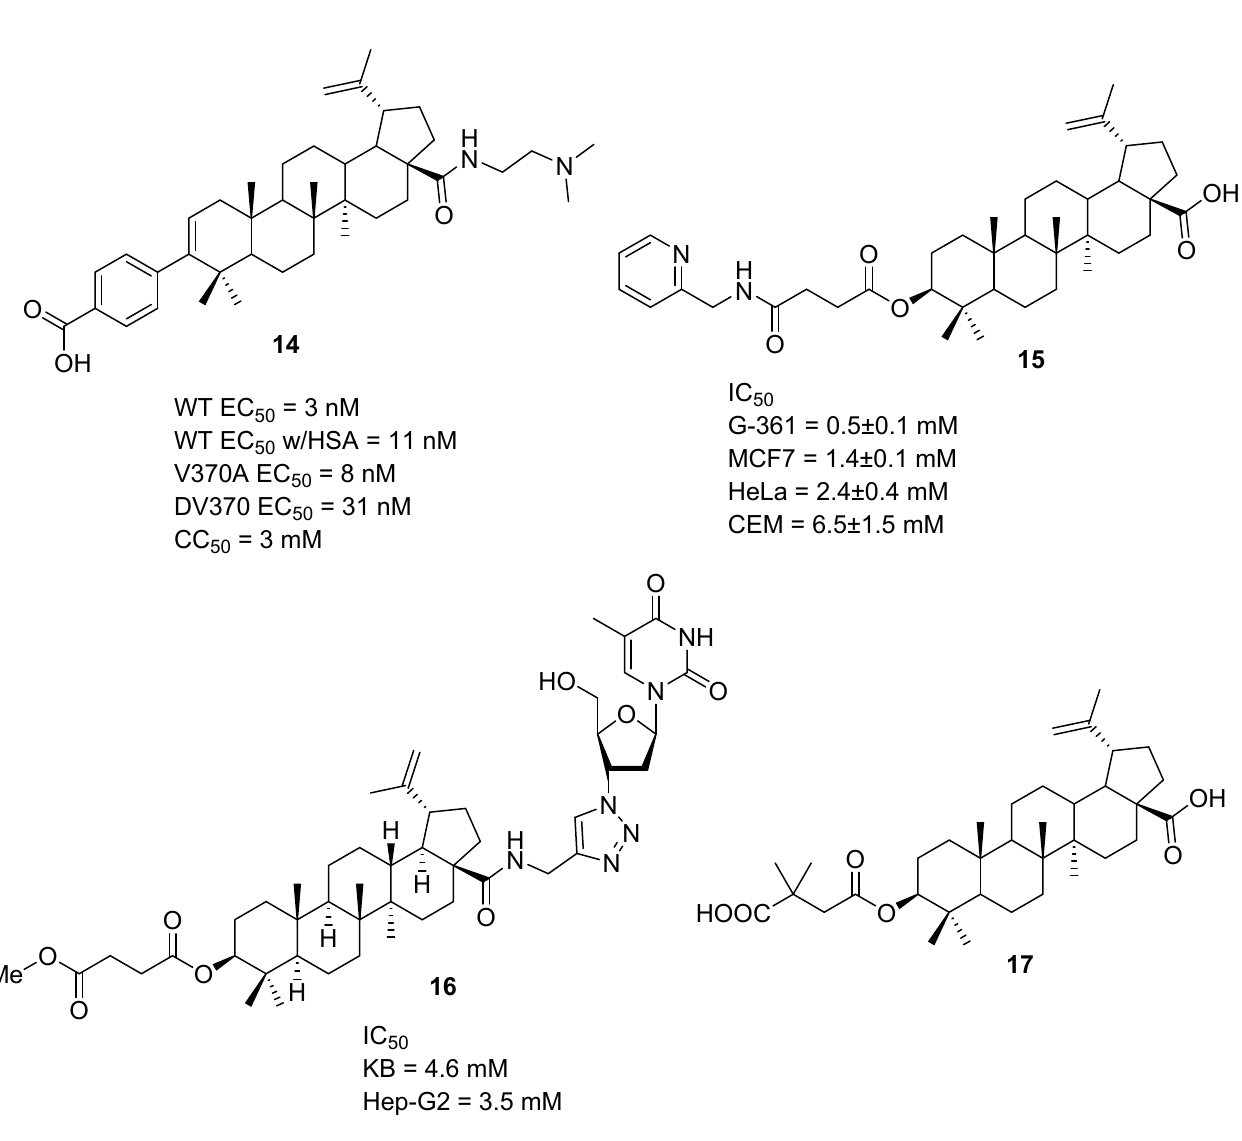
Figure 3. Selected derivatives of betulinic acid ( 5 ) with anti-HIV and anticancer activities.